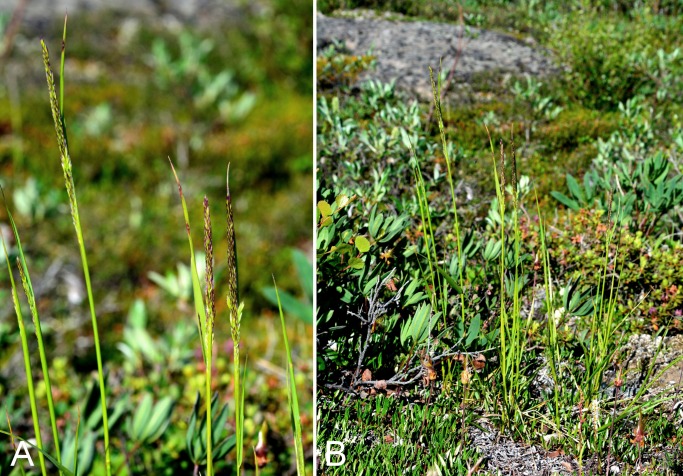
Calamagrostis stricta subsp. groenlandica.(A) Inflorescence, Saarela et al. 4086. (B) Habit, Saarela et al. 4086. Photographs by P. C. Sokoloff.